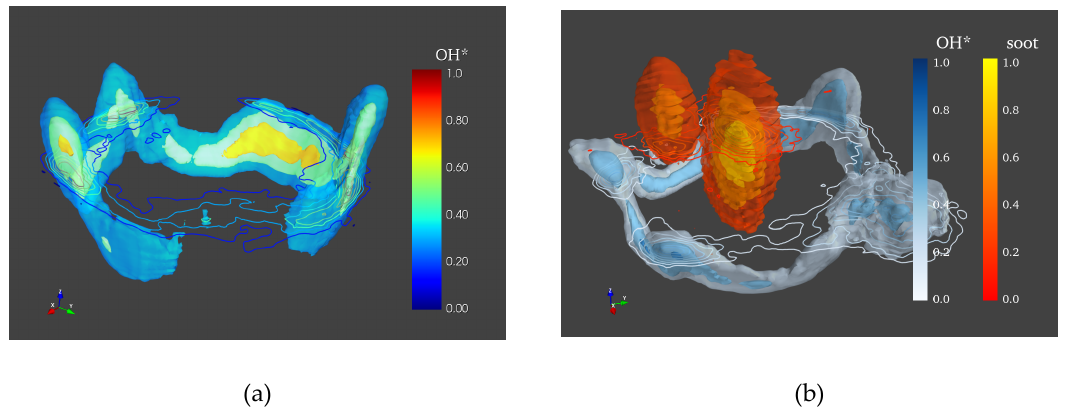
Figure 16. Time averaged 3D distribution of ( a ) OH* in a non-sooting turbulent methane/air diffusion flame (compare Figure 12) and ( b ) of OH* and soot in a sooting turbulent ethylene/air diffusion flame (compare Figure 14).